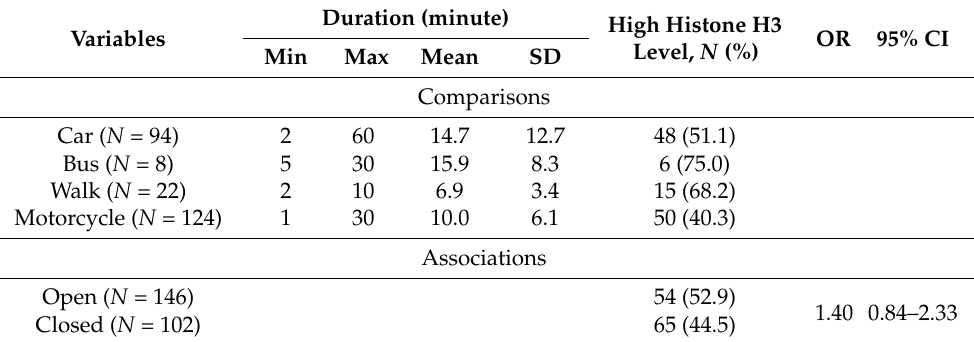
Table 3. Relationships between children’s mode of transport to schools and histone H3 level.